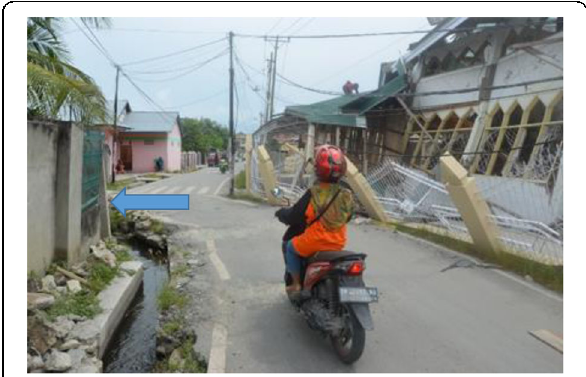
Fig. 7 Large ground displacement of 5.0m at Pipa Air street in Palu